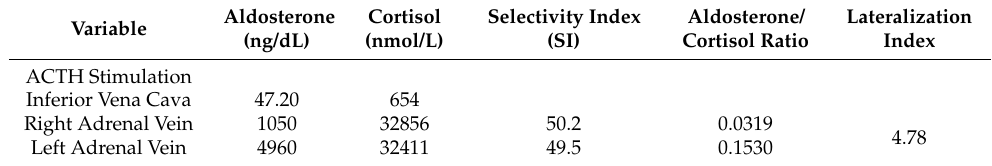
Table 3. Selective adrenal vein